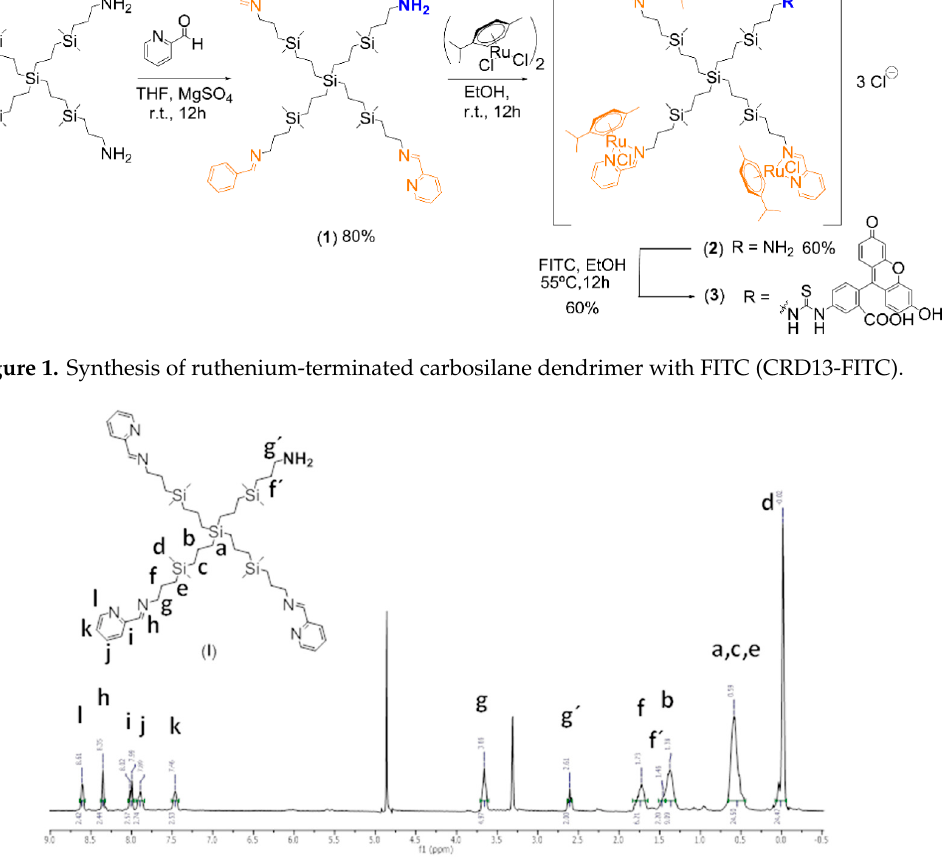
Figure 2. 1 H-NMR spectrum of compound 1 in CD 3 OD.